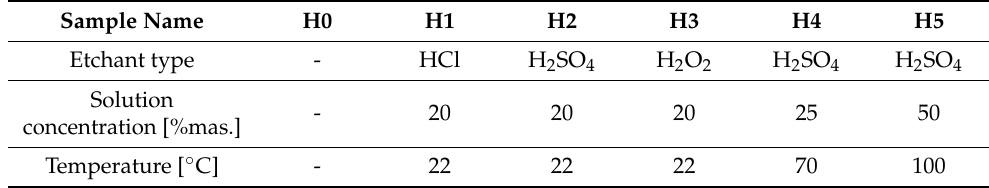
Table 2. Sample identification numbers and treatment